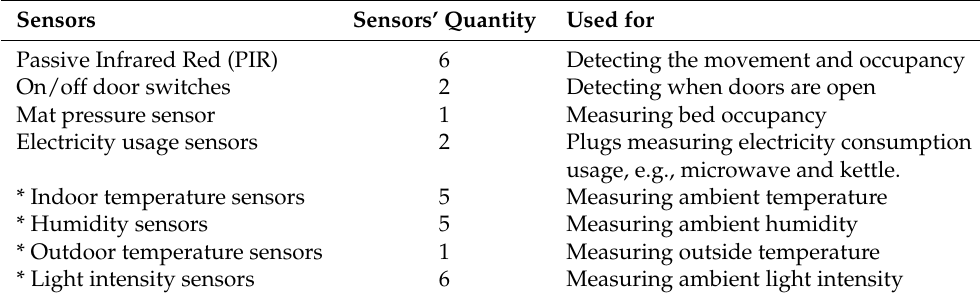
Figure 3. Floor plan layout and location of installed sensors. Table 1. List of sensors used in the experiment that can measure different conditions and activities (* denotes the unused sensors in this